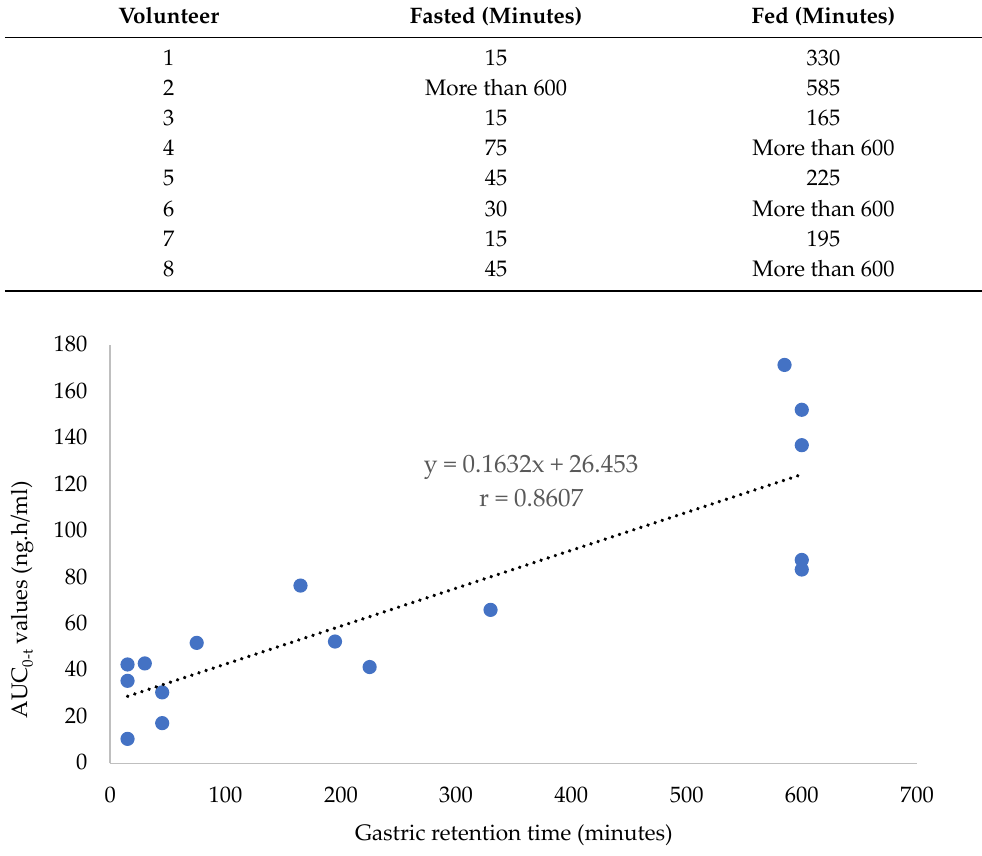
Figure 5. Gastric retention times obtained in fasted and fed state versus the corresponding AUC 0-t values of the floating tablets.